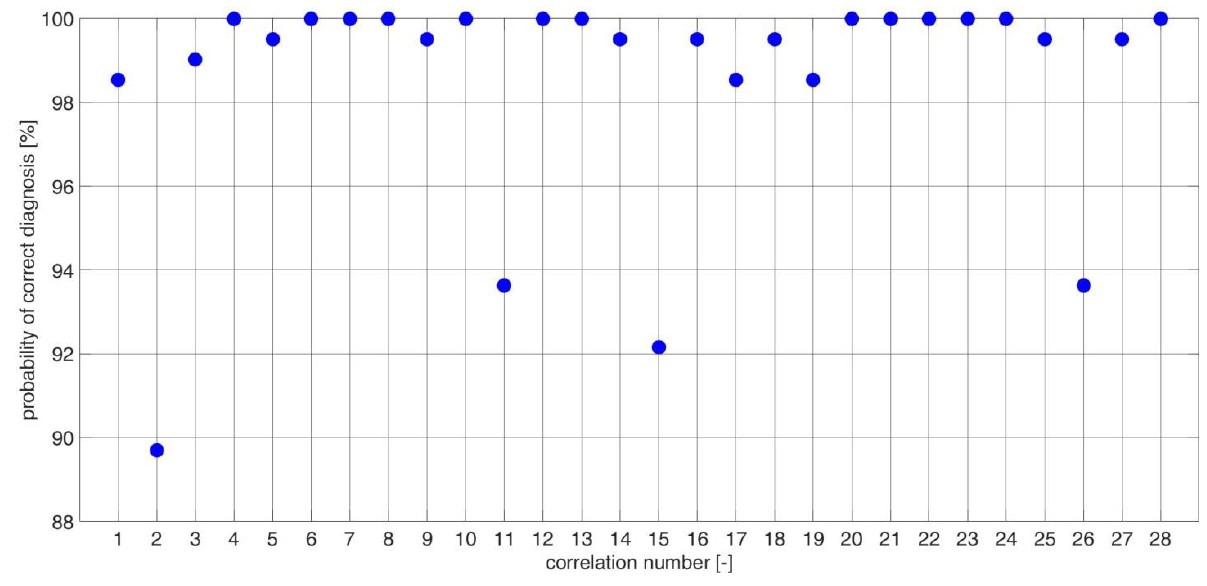
Figure 4. The overall probabilities of correct diagnoses for inner race fault via CCSM3, for each correlation number (Table A1).